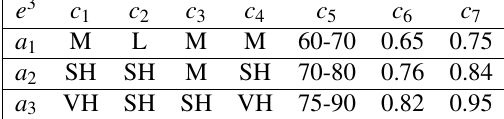
Table 4. Information provided by e 3 expressed in S 9 .